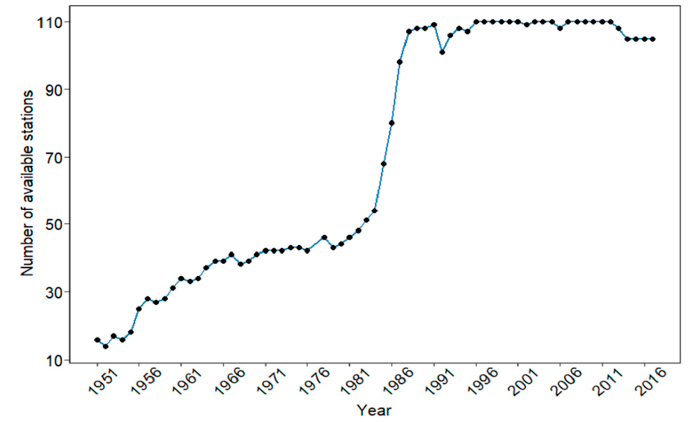
Figure 2. The number of available stations each year.